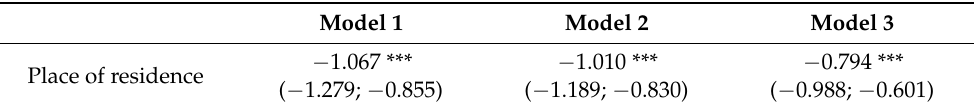
Table 2. Multiple linear regression coefficients of the association between place of residence and cognitive function (N = 10,014).